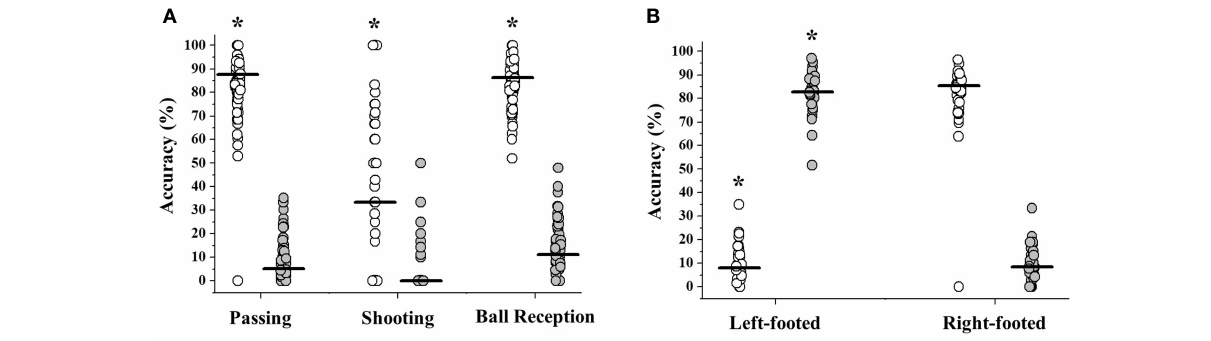
FIGURE 2 | Accuracy values observed for technical actions completed using (A) the dominant (open symbols) or non-dominant limb (gray symbols) in all players pooled. *Significant differences between limbs observed through Wilcoxon’s test ( p < 0.05) and (B) separately for left-footed and right-footed players using the right limb (open symbols) or left limb (gray symbols). *Significant differences between groups using the same limb observed through Mann-Whitney’s test ( p < 0.05). Horizontal lines represent the group median values.